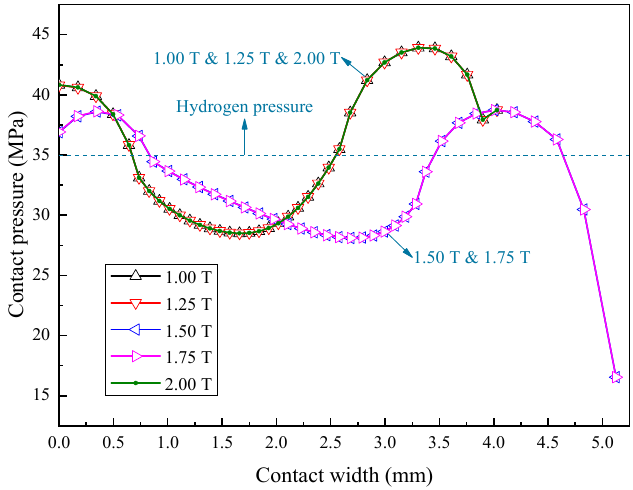
Figure 3. Contact pressure distribution during 0–1 T.